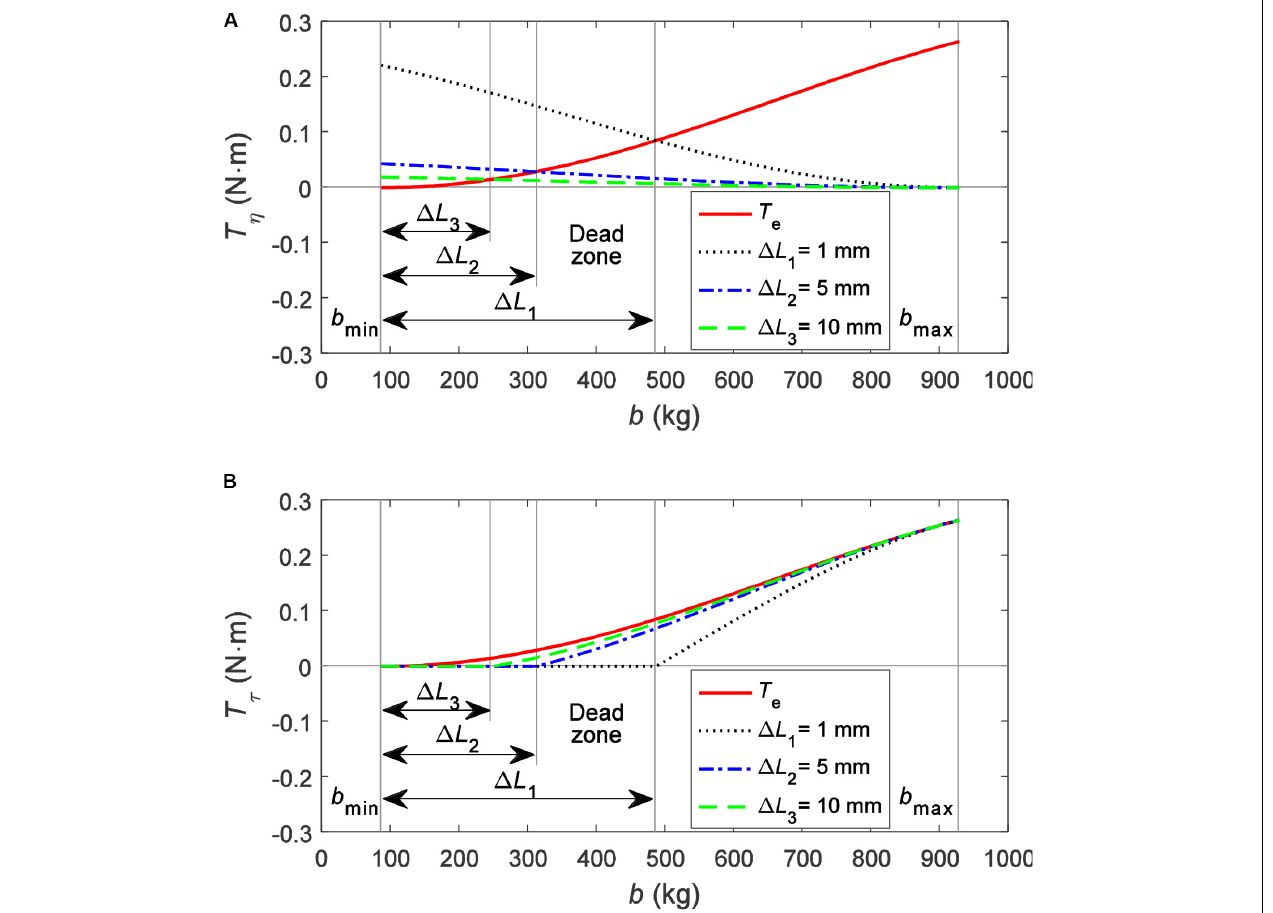
FIGURE 8 | Additional torque under different gap widths: (A) uncontrollable torque and (B) controllable torque.